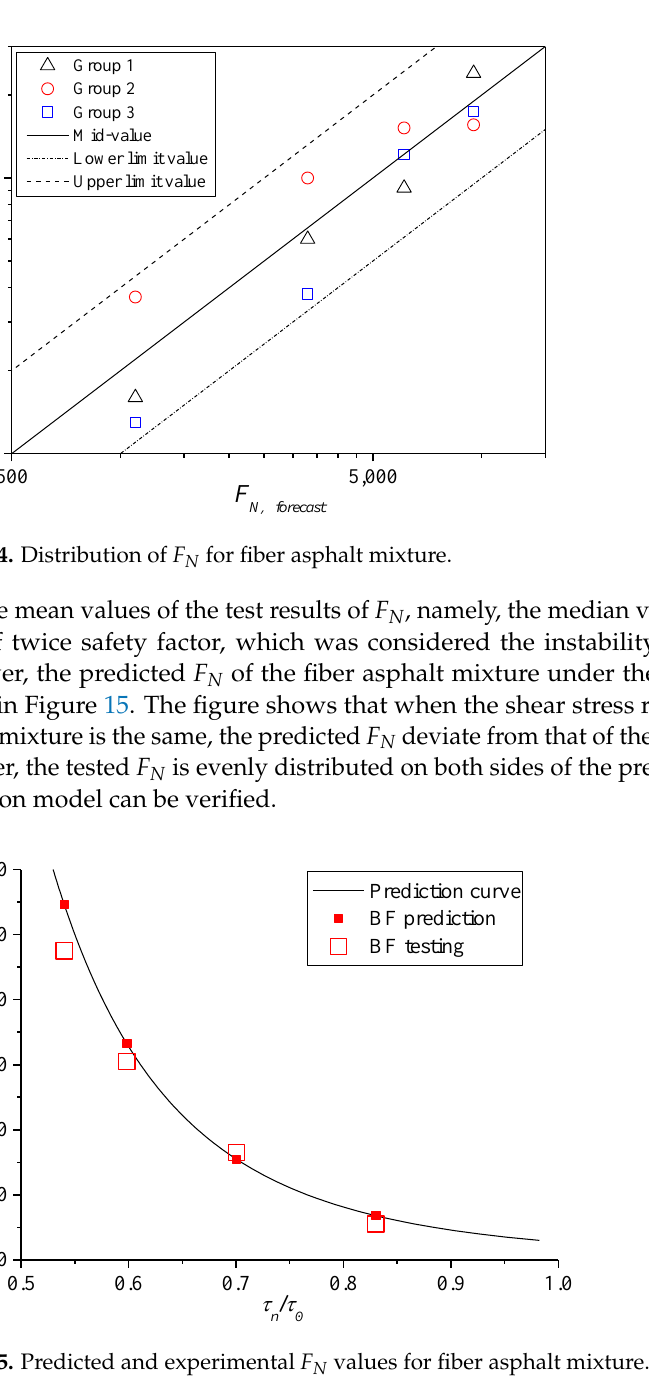
Table 3. F N of fiber asphalt mixture under the 138 kPa confining pressure.